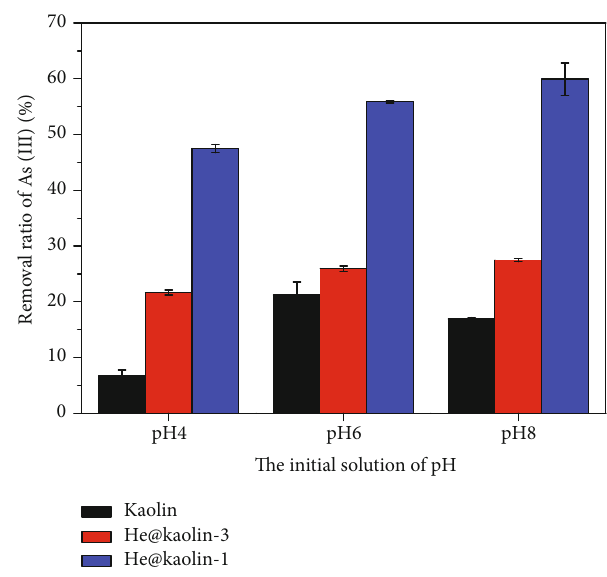
Figure 6: XRD patterns of the adsorption products of kaolin, He@kaolin-3, and He@kaolin-1 at 24 mg/L As(III).